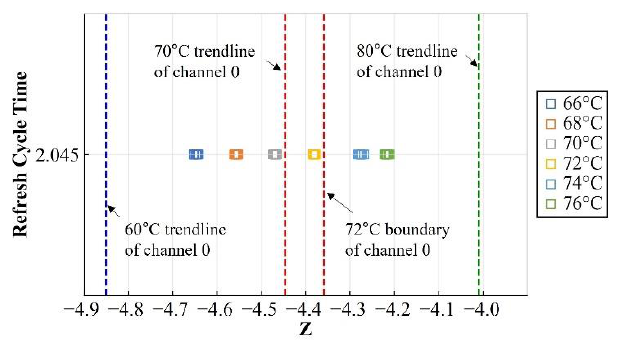
Figure 21. Z-values with T L varying from 66 °C to 76 °C and trendlines and boundaries of Channel-0 at a fixed RCT of 2.045 s, as shown in Figure 19. The Z-values in the dashed vertical lines are from Figure 20 when RCT is 2.045 s. The